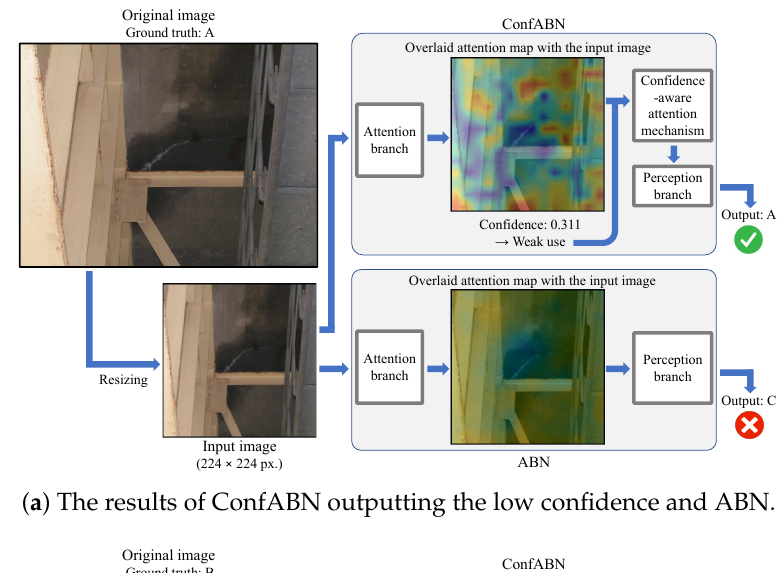
Figure 4. Examples of the estimation results using ConfABN and ABN for the images of corrosion.